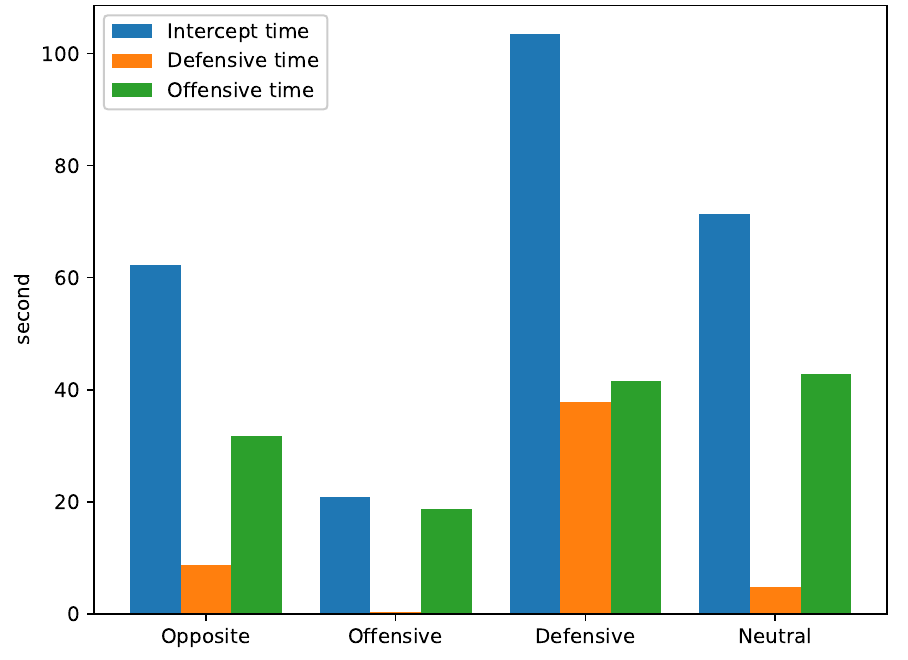
Figure 13. Intercept time T I , defensive time, and offensive time T O of the air combat simulations of PRED-RS-MADDPG strategy versus RS-MADDPG